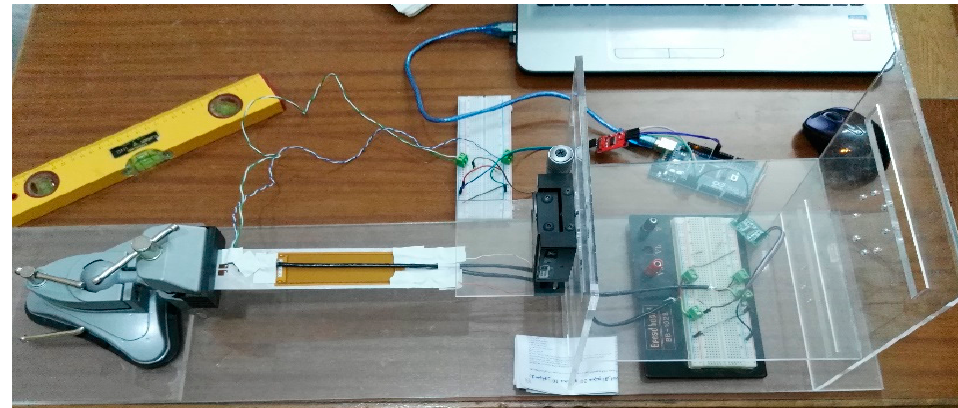
Figure 12. Prototype for the first verification.